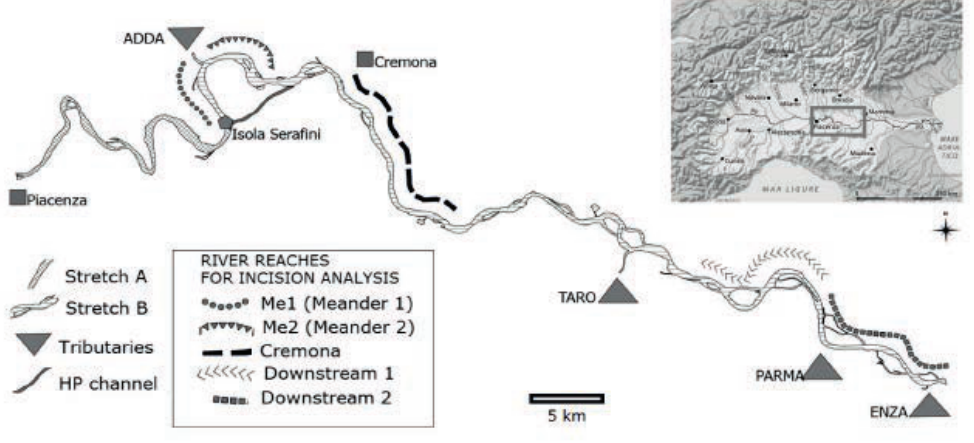
Fig. 2 Middle course of the Po River in